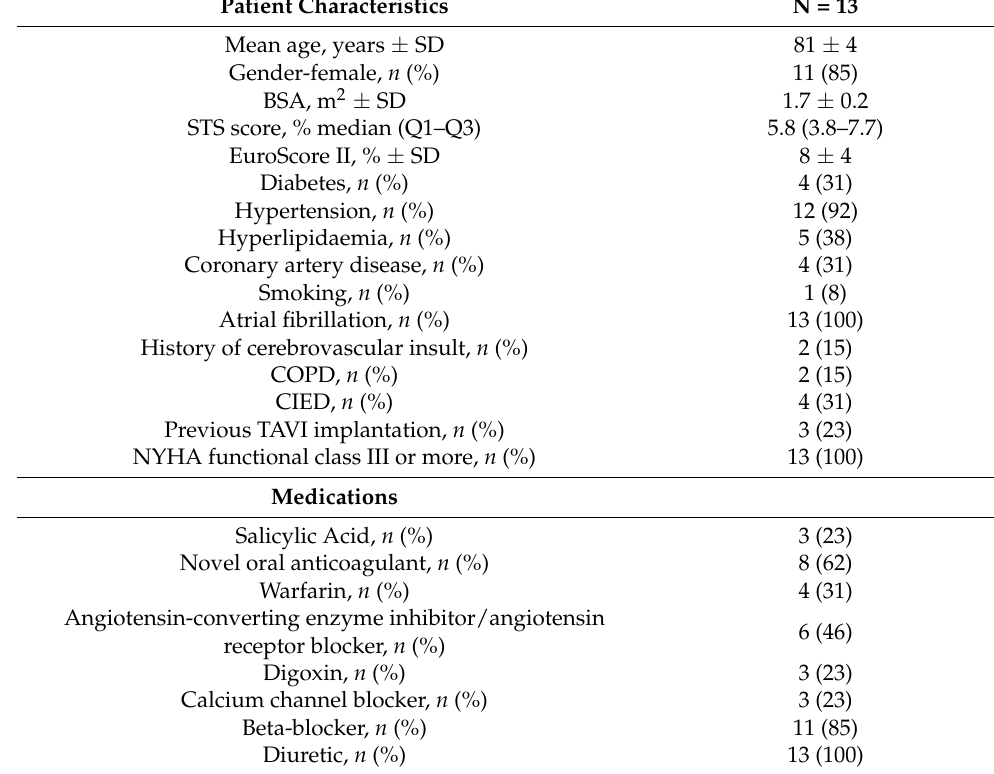
Table 1. Baseline clinical